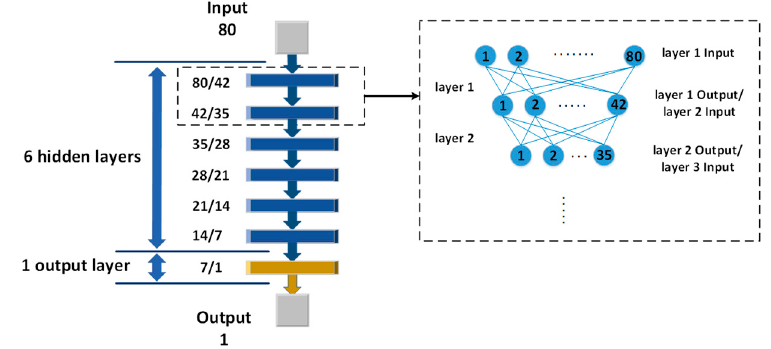
Figure 5. The structure of deep network. The numbers of the elements of the input and the output are marked on the left of each layer in the form of “ I m / O m ” for the m -th layer. All the layers are connected in the same as shown in Figure 1. The details of layer 1 and layer 2 are presented in the right as an example.